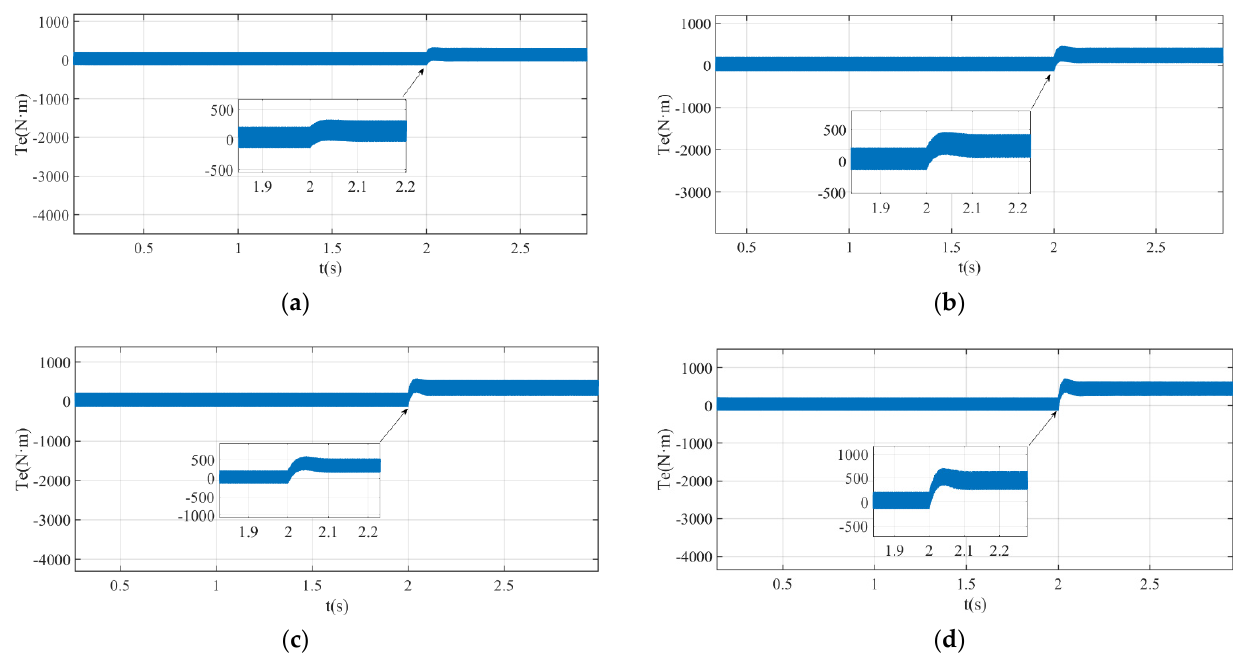
Figure 10. Torque variation under sudden load. ( a ) Sudden 100 N load. ( b ) Sudden 200 N load. ( c ) Sudden 300 N load. ( d ) Sudden 400 N load.